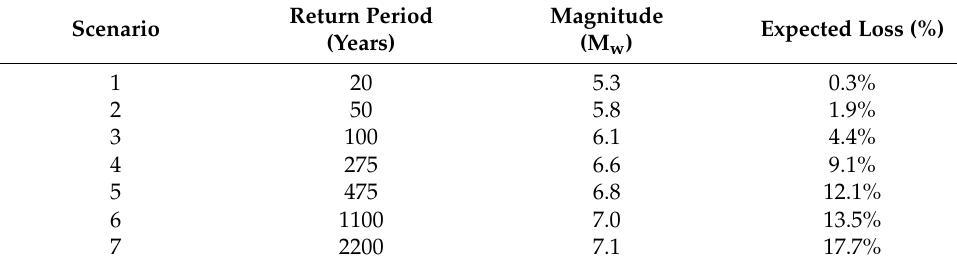
Table 7. Expected losses for the considered seismic scenarios.